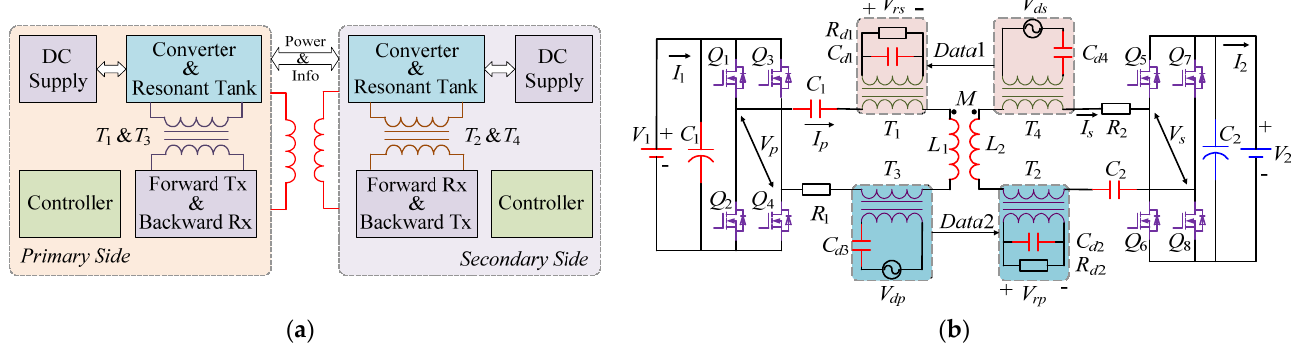
Figure 1. The bi-directional SWIPT system. ( a ) Block diagram. ( b ) Schematic diagram.